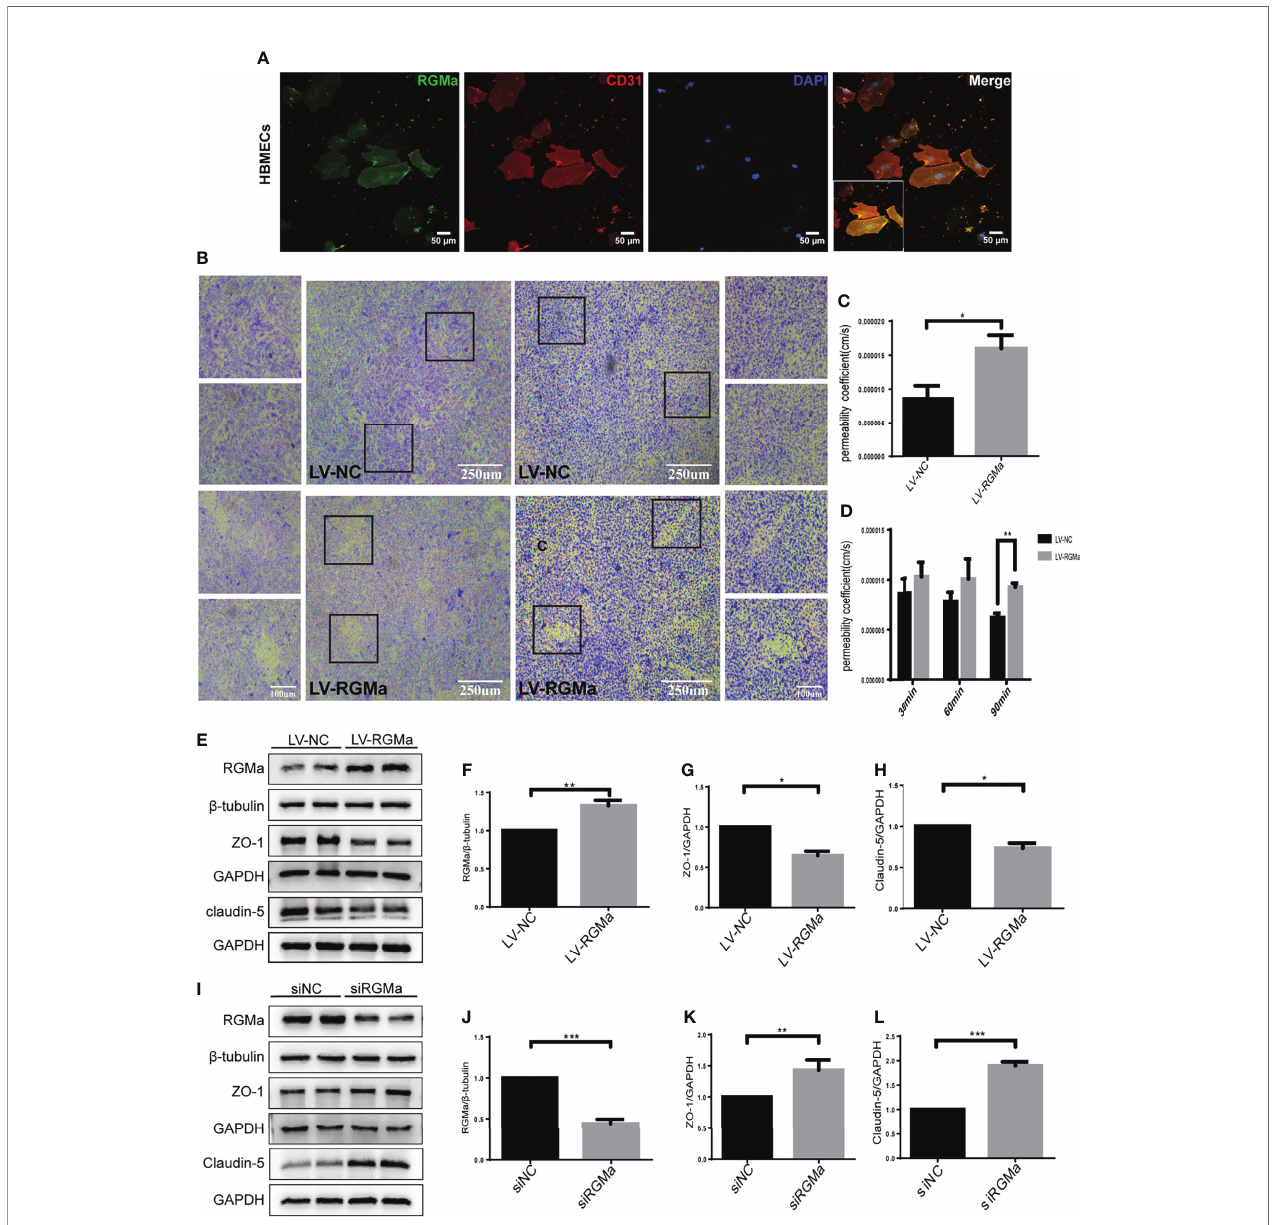
FIGURE 2 | RGMa deteriorates the integrity of the in vitro BBB by HBMECs. (A) RGMa was expressed in CD31 + HBMECs. Scale bar: 50 µm. (B) The permeability of in vitro BBB was detected by crystal violet staining and FITC-dextran-4 kDa (right) or 70 kDa (left) assay. Overexpression of RGMa signi fi cantly exacerbates BBB permeability (error bar: SEM; ** p < 0.01, scale bar: 250 µm). (C) After 90 min, the permeability coef fi cient of FITC-dextran-70 kDa in the LV-NC and LV-RGMa groups. (D) After 90 min, the permeability coef fi cient of FITC-dextran-4 kDa in the LV-NC and LV-RGMa groups. (E – L) By speci fi cally upregulating or downregulating RGMa, the expression of ZO-1 and claudin-5 were accordingly decreased or increased ( n = 3, error bar: SEM; * p < 0.05, ** p < 0.01, *** p < 0.001, t